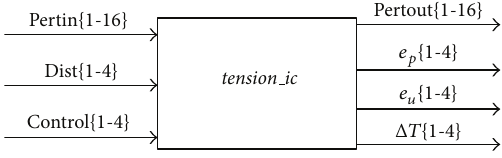
Figure 10: Block diagram of open loop system.